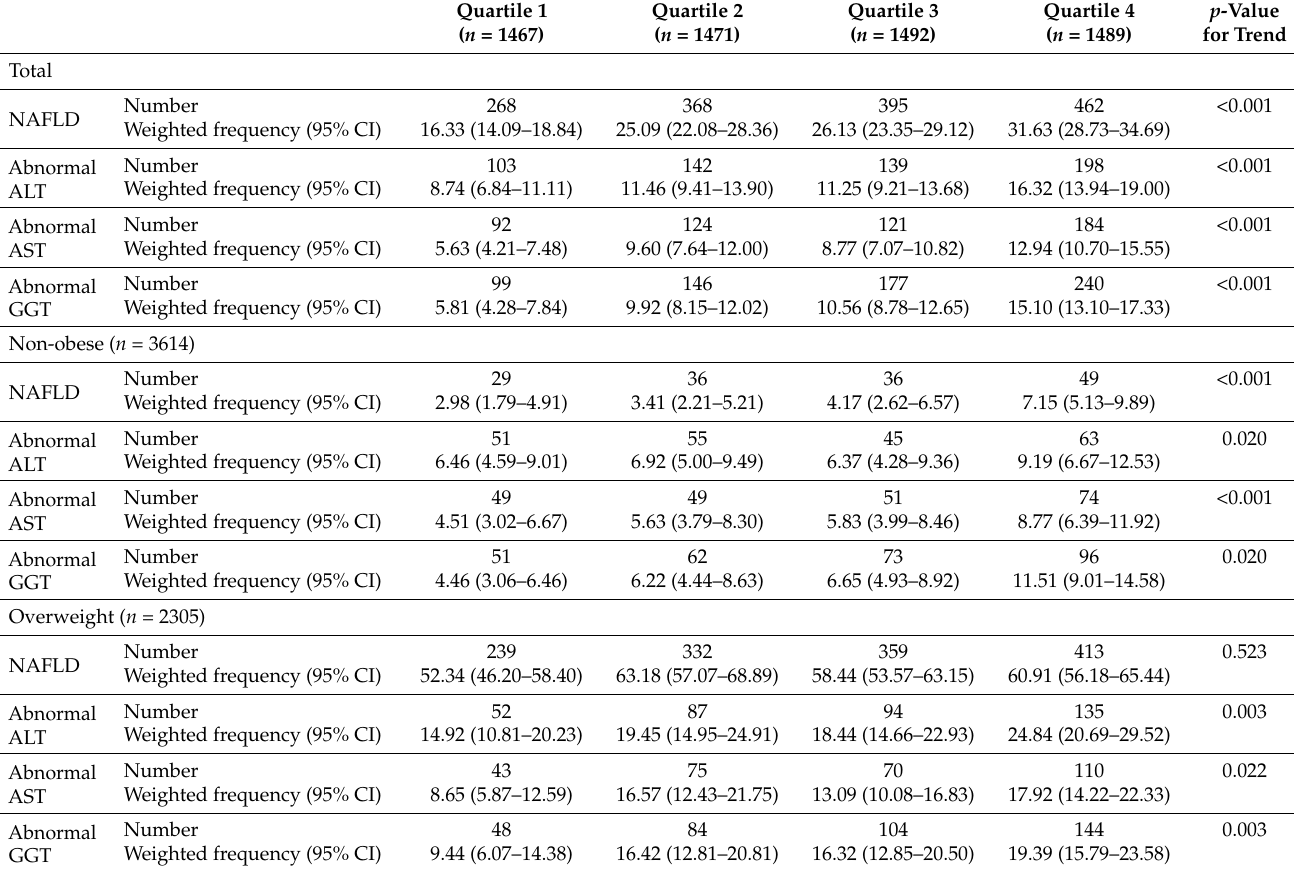
Table 3. Prevalence of NAFLD and abnormal AST, ALT, and GGT activities according to blood mercury levels in the study